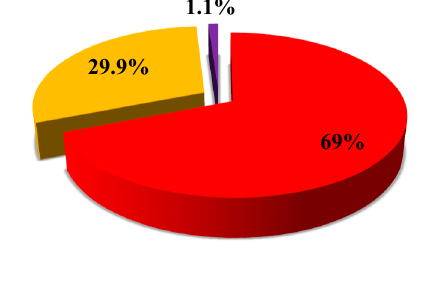
Figure 1. Share of Ghana’s installed power capacity by source in 2020 [14].